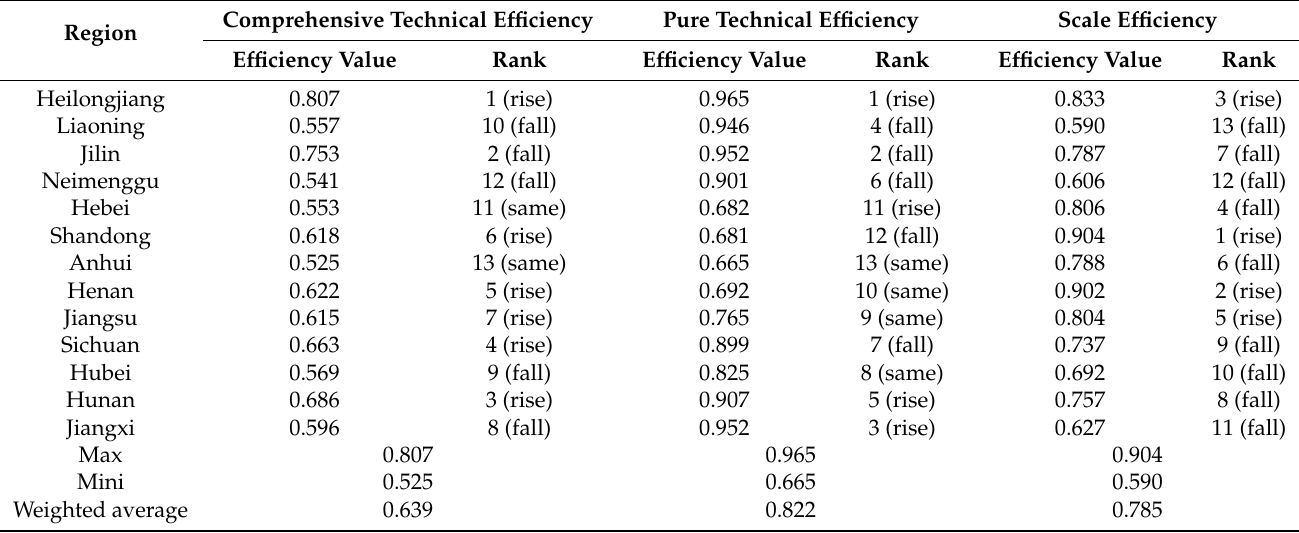
Table 3. The comprehensive technical efficiency, pure technical efficiency, and scale efficiency of grain production resource allocation in major grain-producing areas of China from 2000 to 2019 in the third stage.